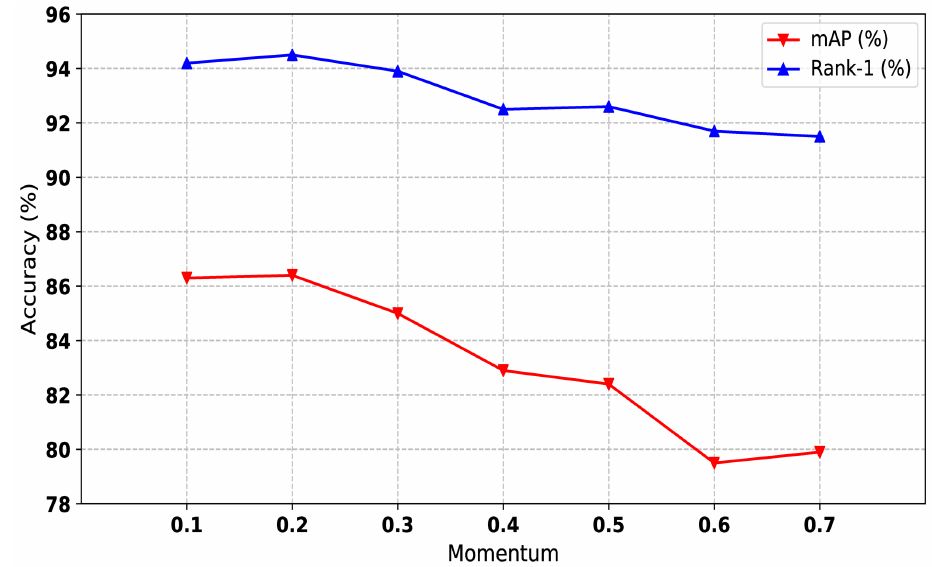
Figure 5. The impact of momentum values of our method on Market1501 dataset. Both mAP and Rank-1 are used to evaluate the performance. The x-axis represents momentum values.